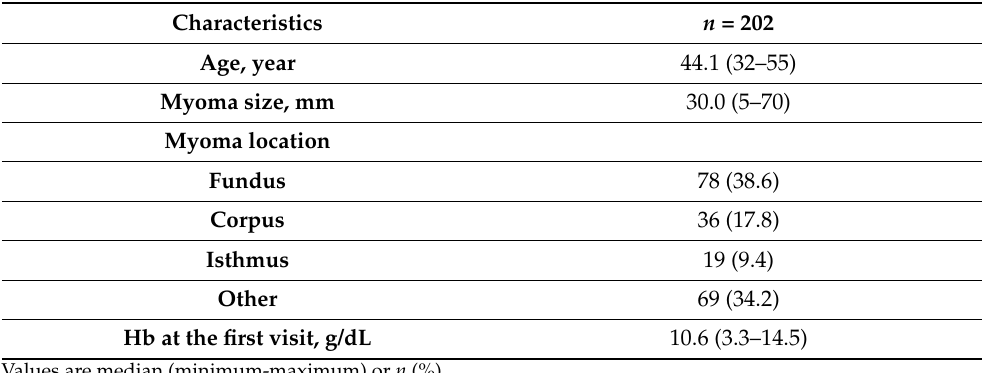
Table 1. Study population characteristics.